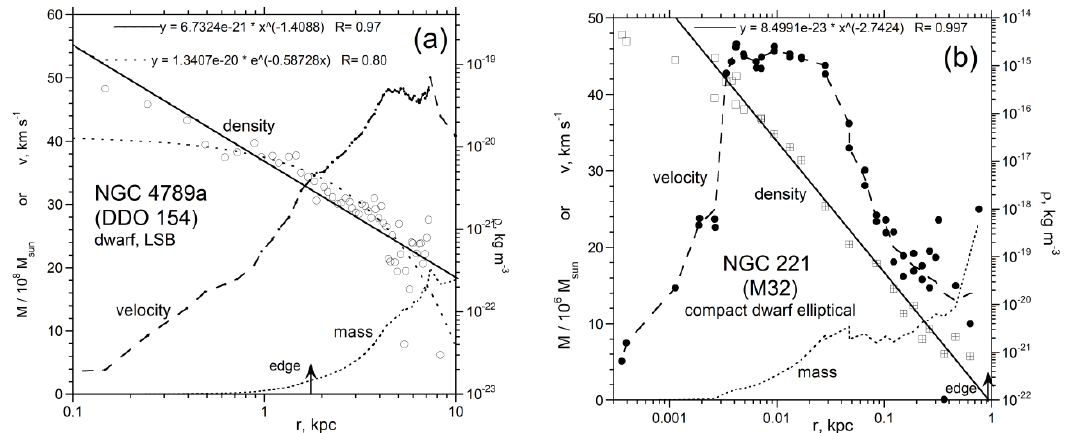
Figure 7. Small galaxies: ( a ) Low surface brightness, dwarf irregular galaxy NGC 4789a. RCs from Bottema and Pestaña [64]. M in ratioed to 10 6 M Sun Two fits to density are shown: solid = power law and dots = exponential; ( b ) Compact dwarf elliptical M32. RCs from Howley et al. [55]. M in ratioed to 10 6 M Sun . Density above 0.6 kpc is described by a power law, but not an exponential.